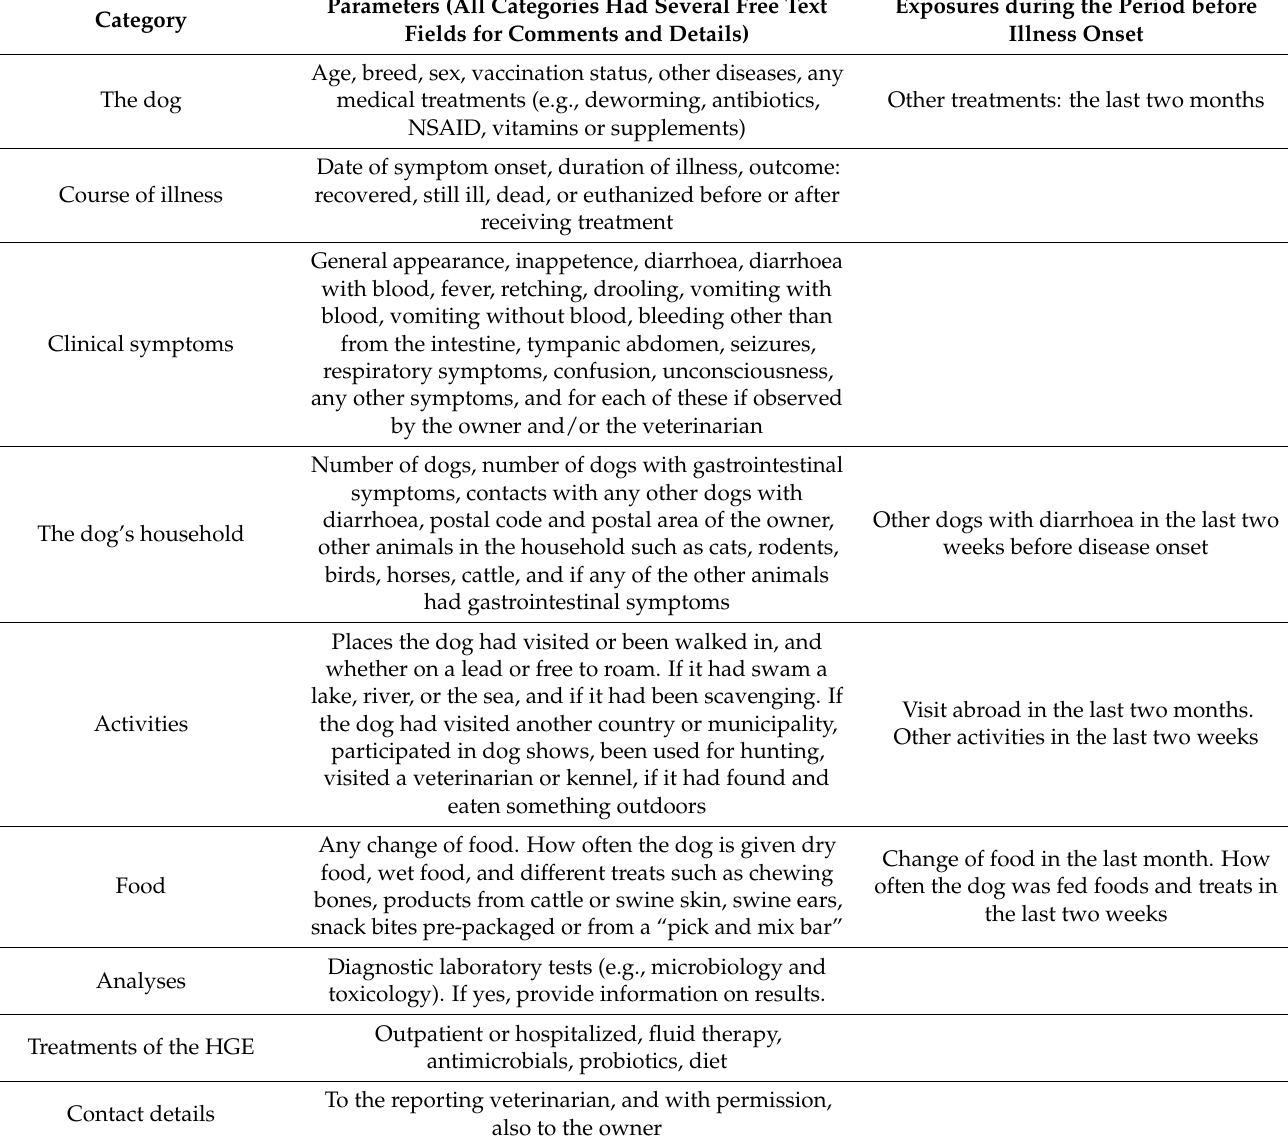
Table 1. Summary of questions in an online survey to veterinarians with dog patients with acute haemorrhagic diarrhoea (AHD) in dogs, Norway, September